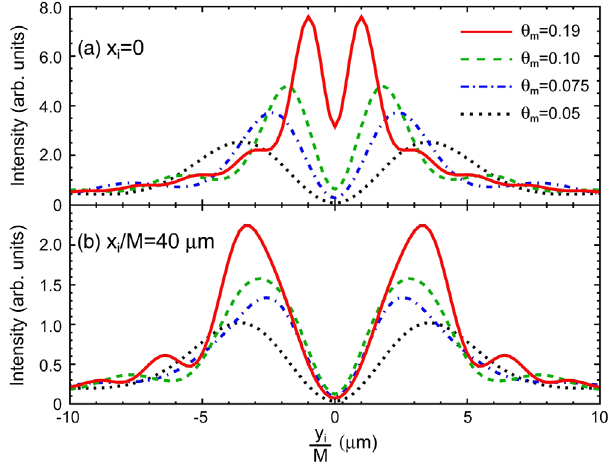
FIG. 6. Examples of vertical beam image cross sections, taken from Fig. 5 at two different horizontal positions (a) x i ¼ 0 and (b) x i =M ¼ 40 μ m with the numerical aperture θ m as parameter: θ 0 . 19 (red solid line), θ 0 . 10 (green dashed line), θ m ¼ m ¼ m ¼ 0 . 075 (blue dash-dotted line), and θ 0 . 05 (black dotted m ¼